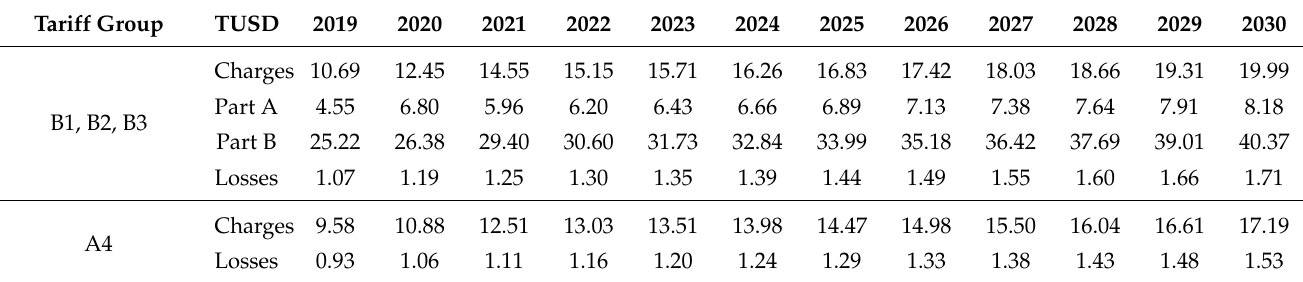
Table A4. Distribution System Use Tariffs (TUSD) by tariff group and components for Enel Goi á s, in